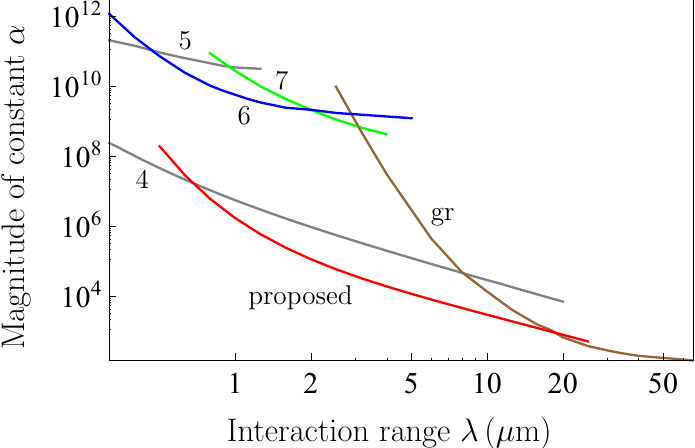
Figure 9. The constraints on Yukawa-type correction to Newton’s gravitational law, which can be obtained from the proposed CANNEX test are shown by the line “proposed” as a function of the interaction range. For comparison purposes, the lines 4–7 and the line labeled “gr” are reproduced from Figures 3 and 7, respectively. The regions above each line are excluded and below each line are